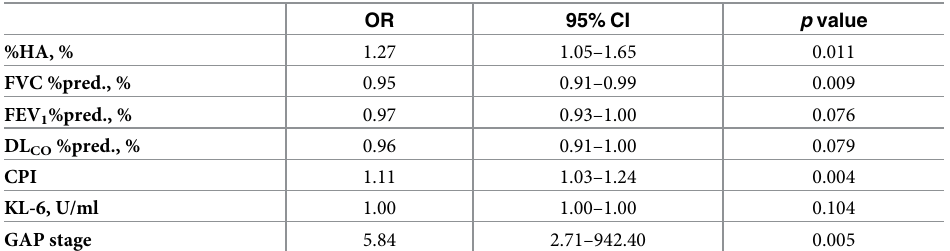
Table 4. Results of univariate logistic regression analysis for predictors of mortality.